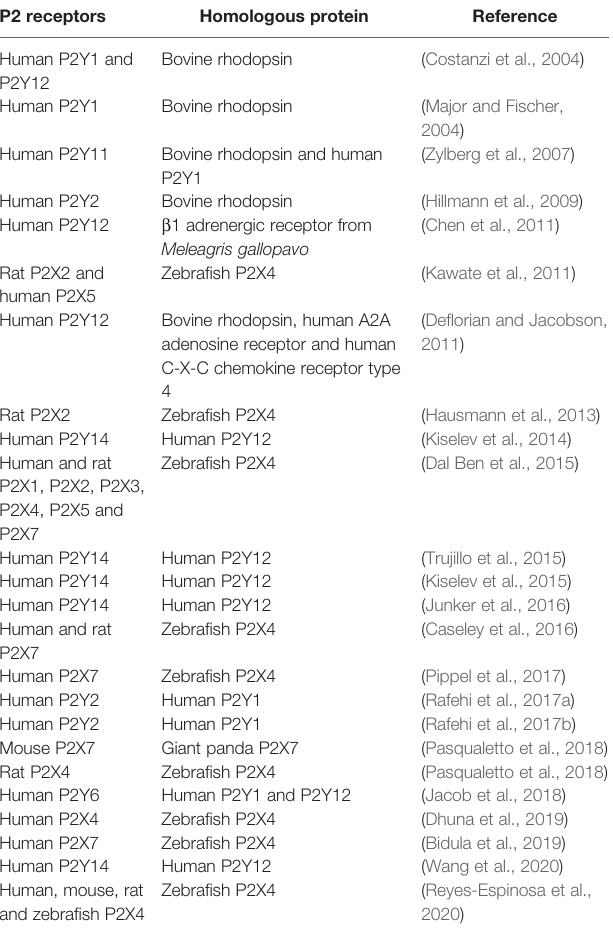
TABLE 1 | Comparative protein structure modeling methods in the structure prediction of P2